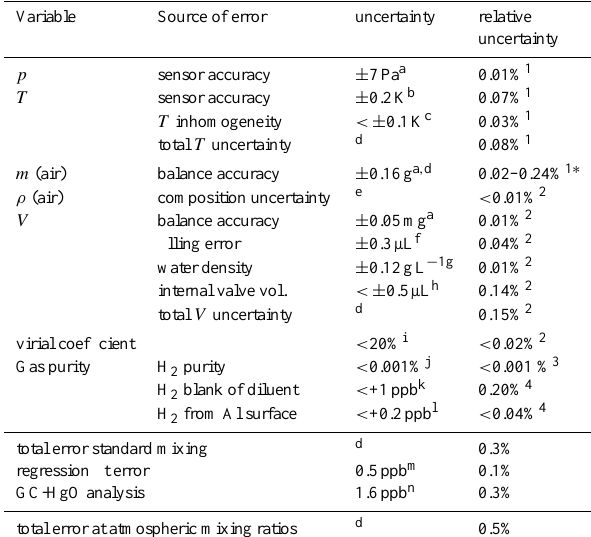
Table 3. Contributing factors to the uncertainty of the H 2 mixing